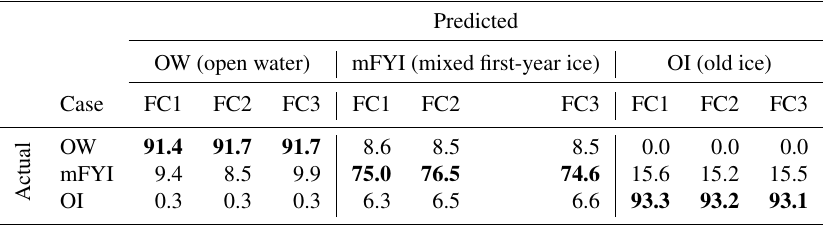
Table 11. Confusion matrix of the three-class RF classifier which was trained with the DS1 winter dataset and applied to the DS2 winter dataset. The bold font indicates where the classification was done correctly. Predicted OW (open water) mFYI (mixed first-year